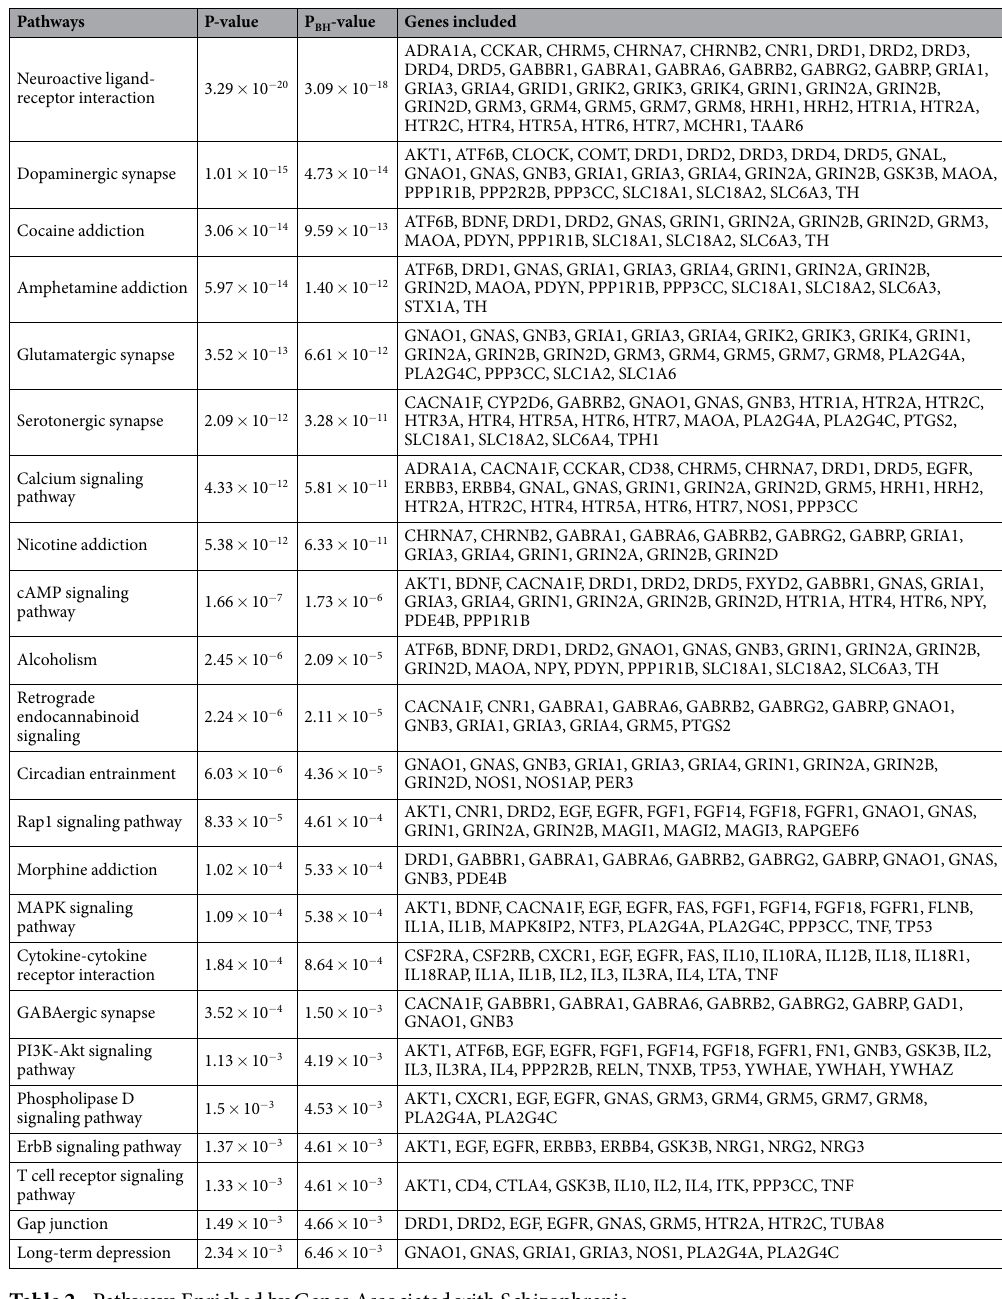
our results show that the membrane receptor proteins participating in drug addiction pathways, such as nAChRs and μ opioid receptor (MOR), may be the potential target for therapeutic treatment for schizophrenia. In fact, the participation of several subtypes of neuronal nAChRs has been explored as therapeutic targets for treatment of various diseases such as pain, schizophrenia and Alzheimer’s disease 60 . Earlier study has found that the expression level of MOR mRNA is higher in schizophrenia, which may contribute to suppressed GABA neuron activity in prefrontal cortical which result in cognitive impairments in schizophrenia 61 . Besides, a recent study demonstrated that genetic variation of MOR in schizophrenics was closely related to their smoking differences 62 . However, the utilization of MOR in the therapeutic treatment for both nicotine addiction and schizophrenia still requires further investigation. Through network analysis, we found that a large number of dysfunctional PPI pairs involved in nicotine addiction or schizophrenia, and several common PPI pairs co-occurrence in both diseases were employed to construct a common sub-network for both diseases. By calculating the degree parameter of each node in this common sub-network, we identified 11 susceptible genes potentially involved in both diseases. Most of these genes have been reported to be associated with nicotine addiction, schizophrenia or both diseases through